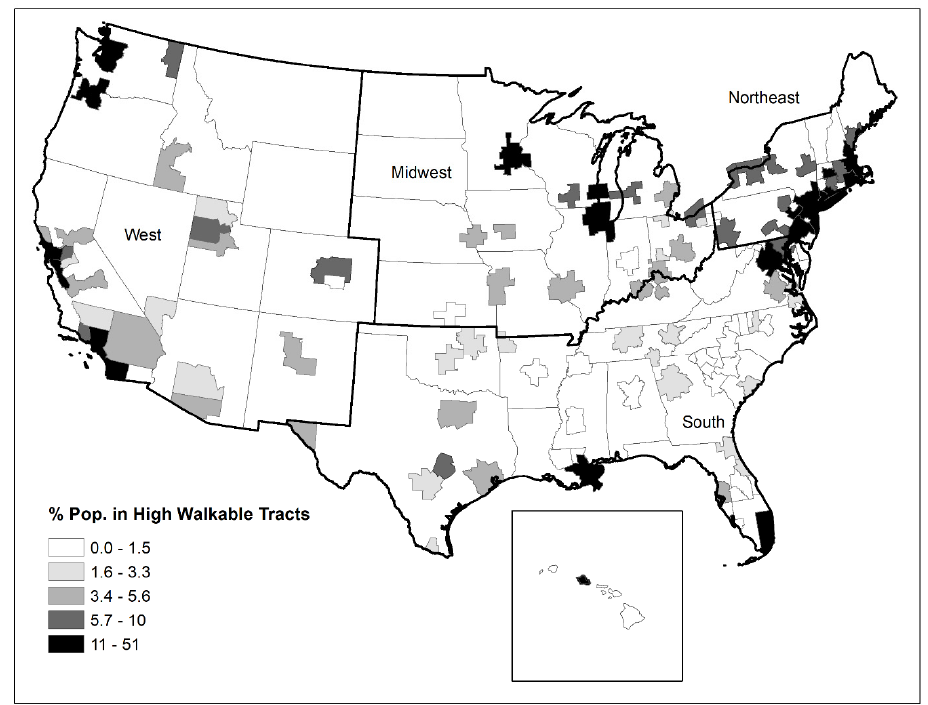
Figure 1. Percentage of urban population residing within highly walkable (walk score ≥ 70) census tracts by metropolitan area. Note the four U.S. Census regions used in the regression analysis.